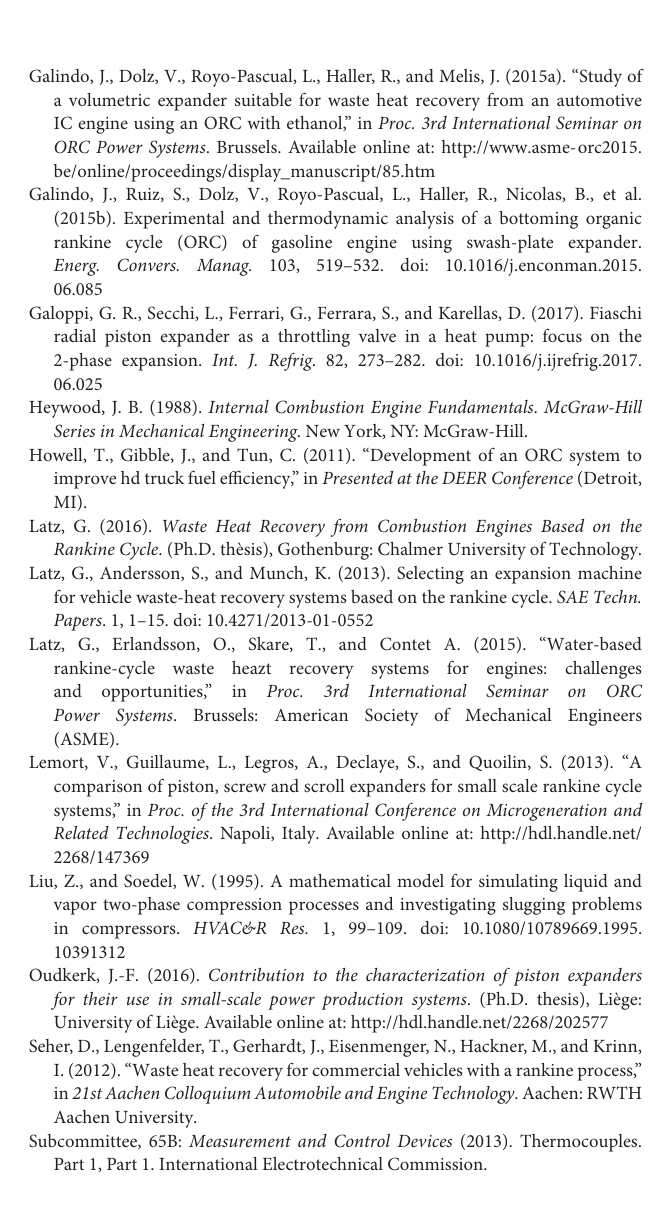
Supplementary Table 2 | Experimental data and expander geometrical